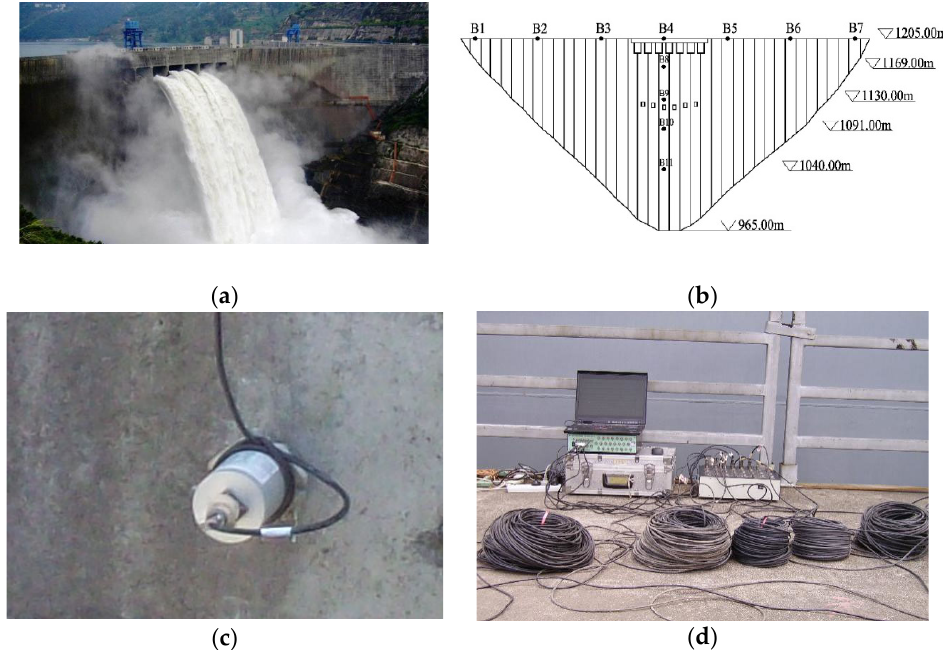
Table 1. Test conditions of discharge vibration of arch dam prototype.